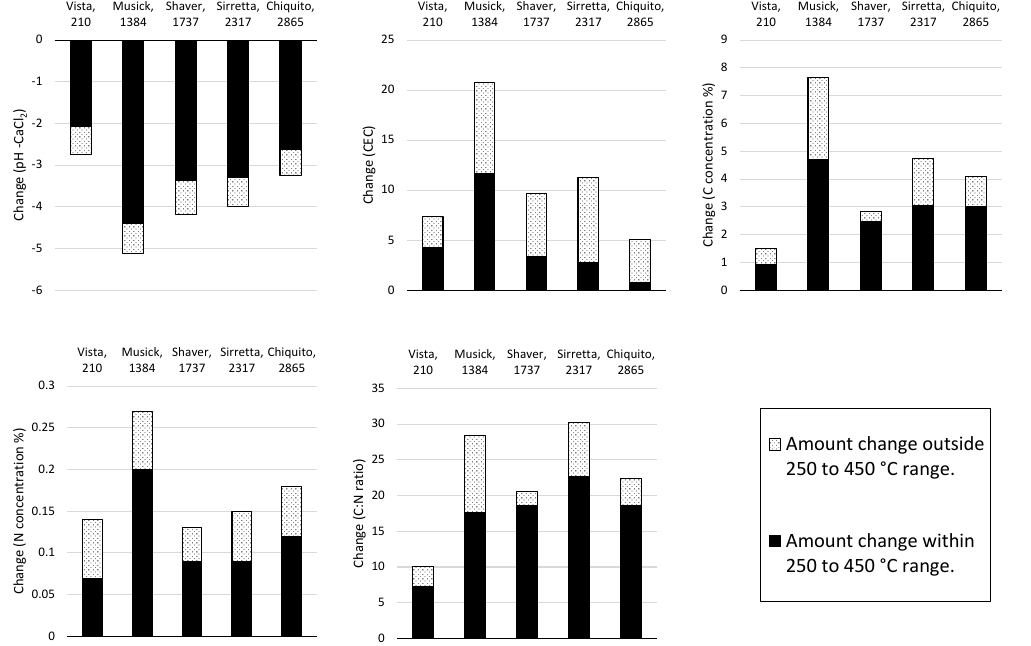
Figure 10. Total amount of change from unburned to 650 ◦ C combusted soils showing amount of change within the 250 to 450 ◦ C